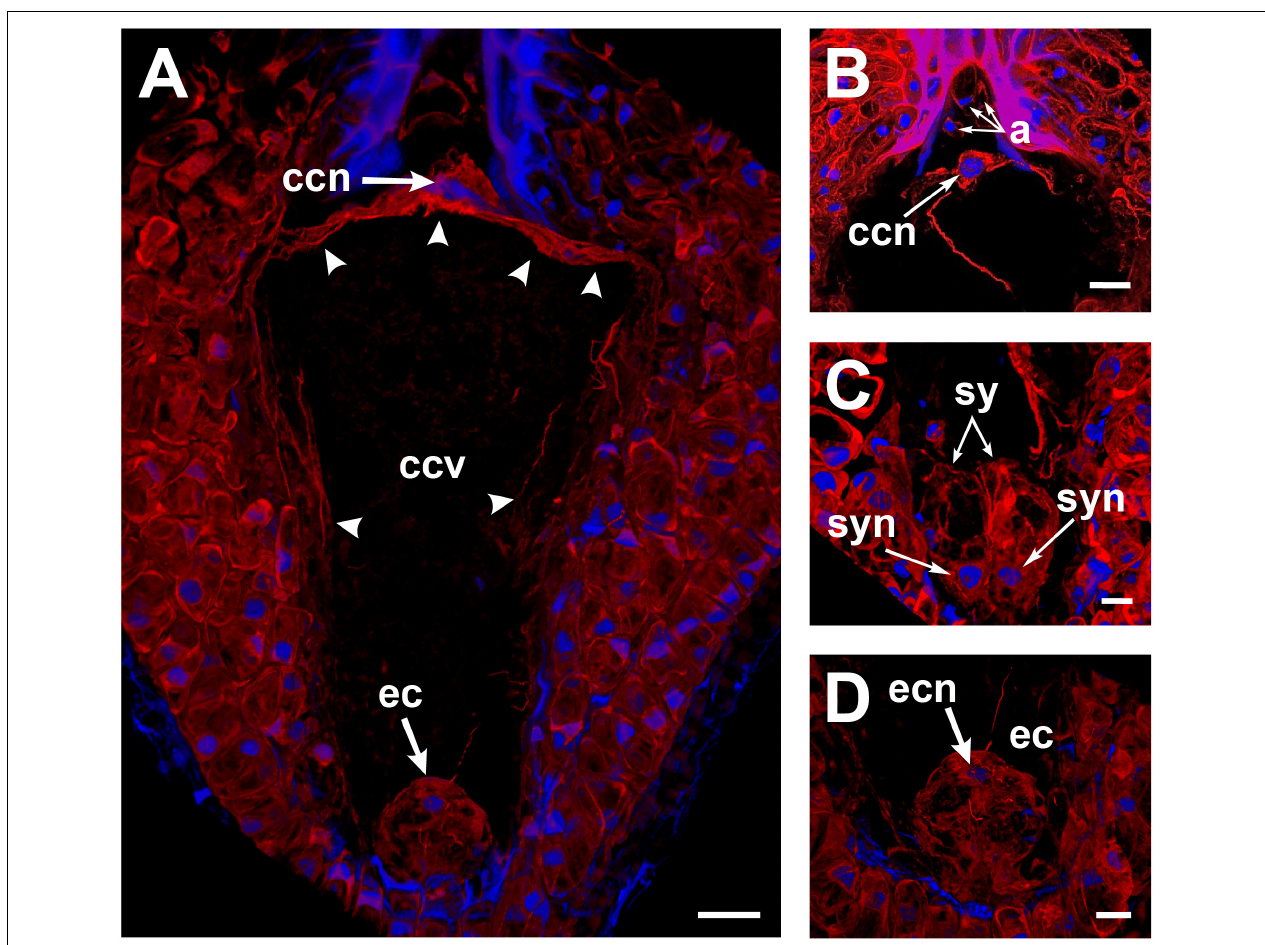
FIGURE 2 | Perinuclear and cortical F-actin in the Agave inaequidens mature embryo sac from time “0” up to 18 HAP. (A) Rhodamine-phalloidin-stained actin filaments were located at the periphery of the central cell. (B) The central cell nucleus displayed a dense perinuclear F-actin coat, while it was less abundant in the antipodal cells. (C) F-actin was denser at the synergids’ micropylar end, where their nuclei were located. (D) Egg cell cortical and perinuclear actin filaments. ccn, central cell nucleus; ccv, central cell vacuole; a, antipodal cells; sy, synergids; syn, synergid nucleus; ec, egg cell; ecn, egg cell nucleus. Arrow heads, cortical actin filaments of the central cell. All micrographs are z-stack projections oriented with the chalazal pole at the top. Bar in (A–C) = 20 µ m and (D) = 10 µ